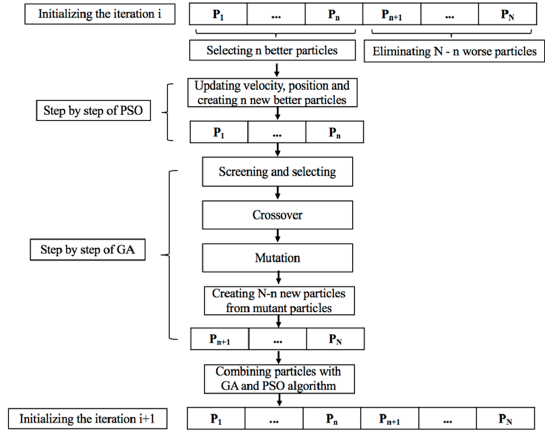
Figure 7. The combination method of Q. Zhang repoduced from [15], Appl. Energy: